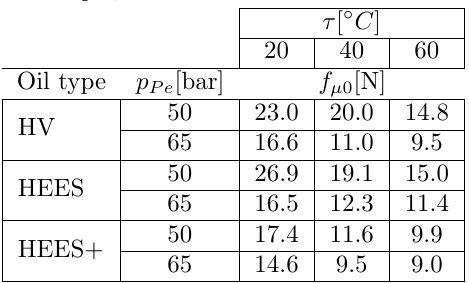
Table 7: f µ 0 for 20, 40 and 60 ◦ C for the p Pe =50bar and p Pe =65bar data sets and all three oils.